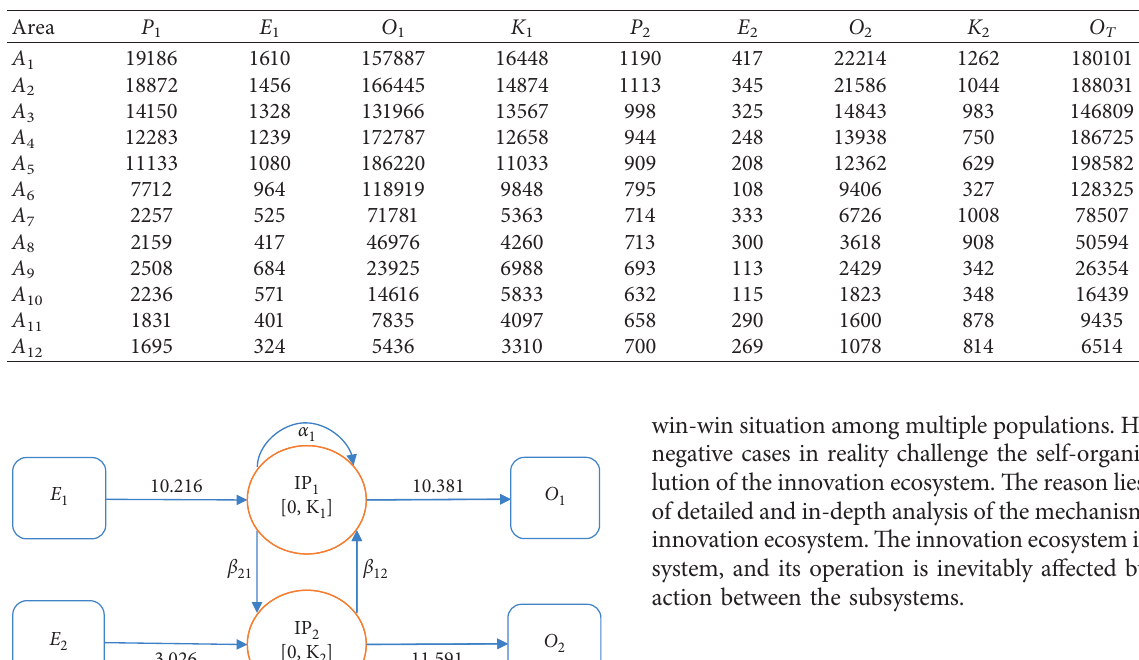
Table 3: Relevant data for the example.